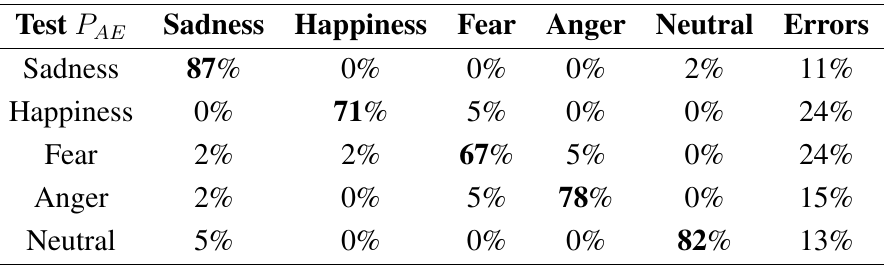
Table 10. Robustness of the emotion recognition from speech.